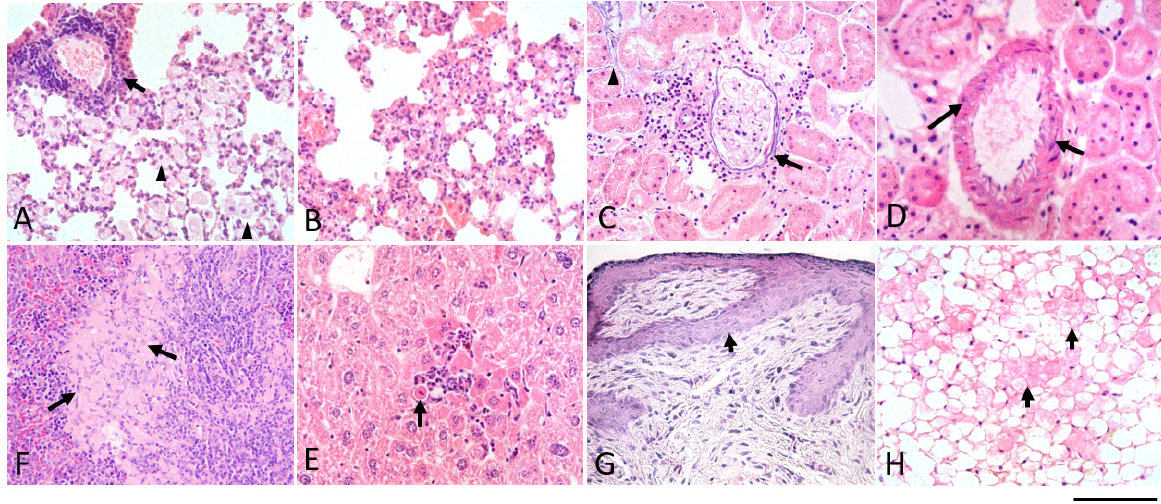
Figure 3. The organs from 12–14-month-old wild-type littermates of Gata1 low mice present a histopathological signature consistent with multisite inflammation. Hematoxylin/eosin staining of representative sections showing the presence of interstitial pneumonia with lymphocytes infiltrating the peri-broncho-vascular space (arrow), macrophages collection in alveoli (arrowheads) ( A ), and irregular thickening of alveolar septa by lymphocytes ( B ); Nephritis with a mixed expression of chronic glomerulonephritis (hypocellular glomerulus) and interstitial nephritis with lymphocytes infiltrating the inter-tubular and perivascular space with basophilic linear deposits along the basement membrane of Bowman’s capsule (arrow) and of tubules (arrowhead) ( C ); Arteriopathy with mural calcification: basophilic granular deposits beneath endothelial cells and between leiomyocytes, i.e., smooth muscle cells around the vessels (arrows) ( D ). Interstitial hepatitis with intralobular collection of lymphocytes surrounding shrunken and hyper-eosinophilic hepatocytes undergoing apoptosis (arrow) ( E ); Interstitial collection of faintly eosinophilic homogeneous material referable to amyloid (arrows) in the spleen ( F ); chronic dermatitis with dermal fibrosis, lack of adnexa, and hyperplasia of epidermis (arrow) with acanthosis in the skin ( G ), and steatonecrosis of the perirenal fat (arrows) ( H ). Magnification 40×. Results are representative of those observed in 15 mice (age ≥ 11 months, nine males and six females).